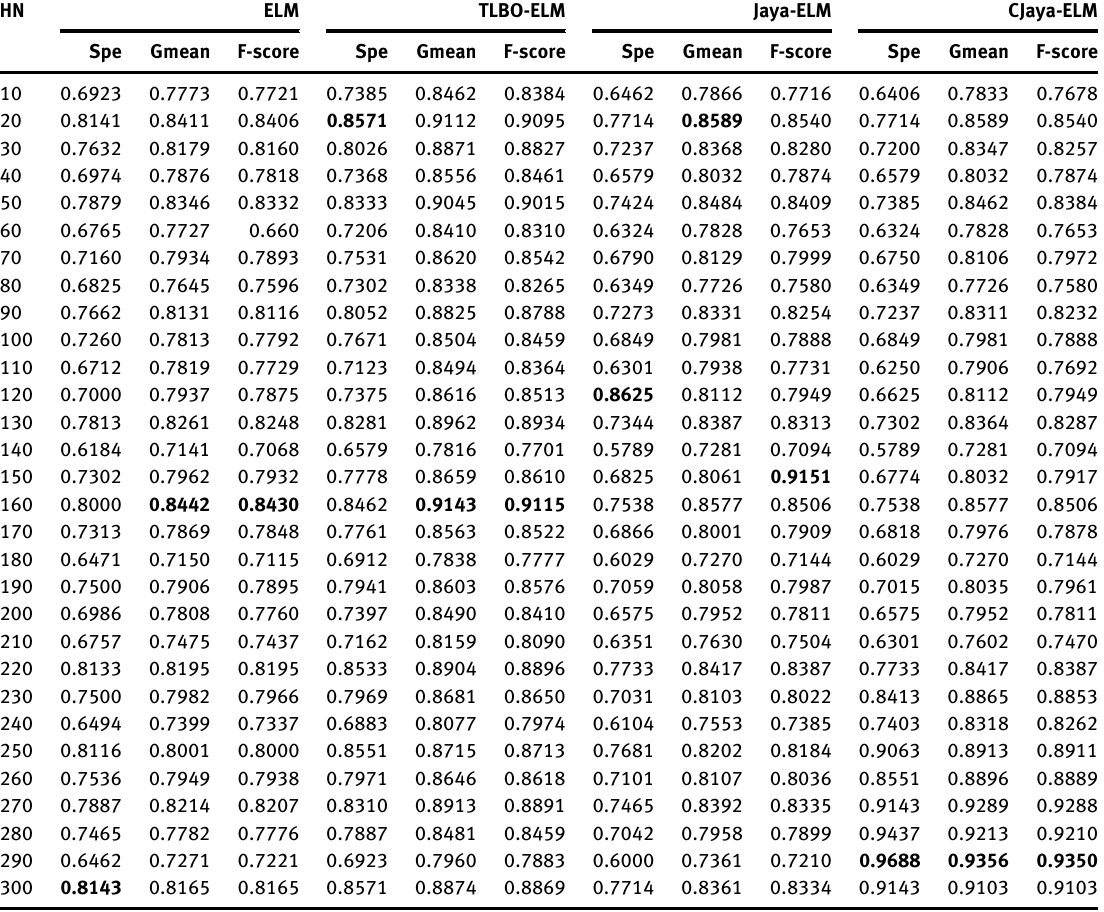
Table  : Speci fi city, Gmean, F-score values for ELM, TLBO-ELM, Jaya-ELM and CJaya-ELM. HN